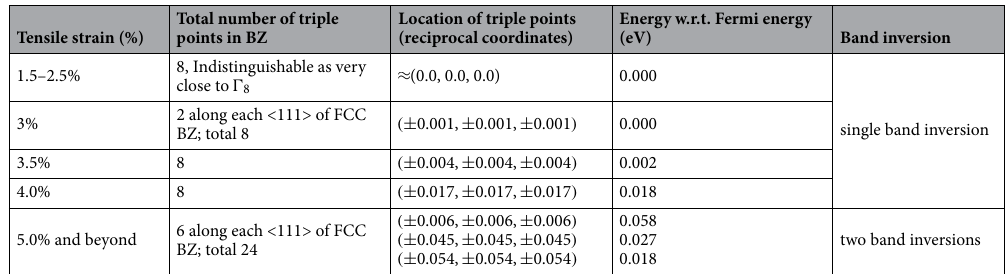
Table 1. Number and momenta of triple points in YPdBi for different values of tensile strain.